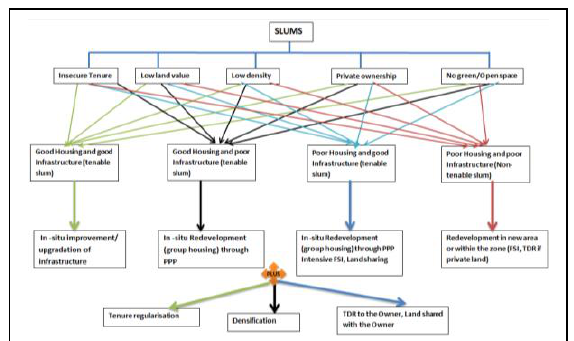
Figure 3 b - Insecure tenure Slums for Improvement, Upgradation and